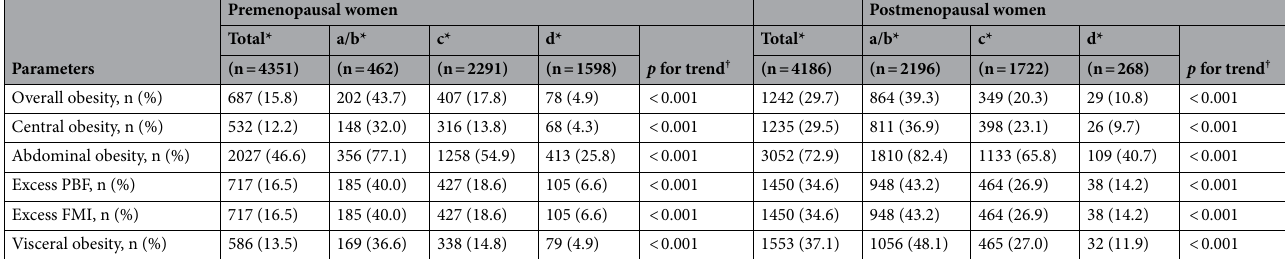
Table 2. Association trend of body fat-driven obesity parameters according to grade of breast density in premenopausal and postmenopausal women. *a, b, c, and d mean grade of mammographic breast density according to BI-RADS in premenopausal and postmenopausal women. and Total is number of total cases in both groups. † p values by linear-by-linear association. Overall obesity, BMI ≥ 25 kg/m 2 ; Central obesity, waist circumference (WC) > 85 cm; Abdominal obesity, waist-hip ratio (WHR) > 0.85; Excessive PBF, PBF ≥ 36.4% which is the highest quartile (Q4) of percent body fat (PBF); Excessive FMI, FMI ≥ 8.85 kg/m 2 which is the highest quartile (Q4) of fat mass index (FMI); Visceral obesity, VFA ≥ 96.3 cm 2 which is the highest quartile (Q4) of visceral fat area (VFA).